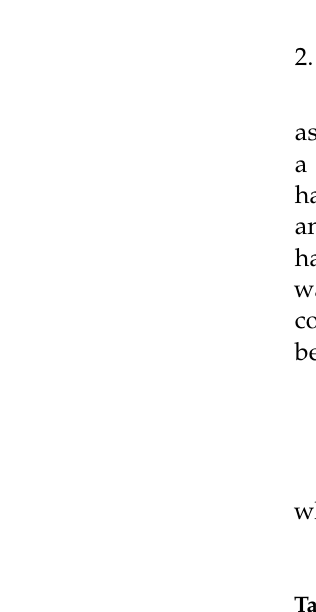
Table 2. Inter-channel errors (250SPS, PGA = 1).